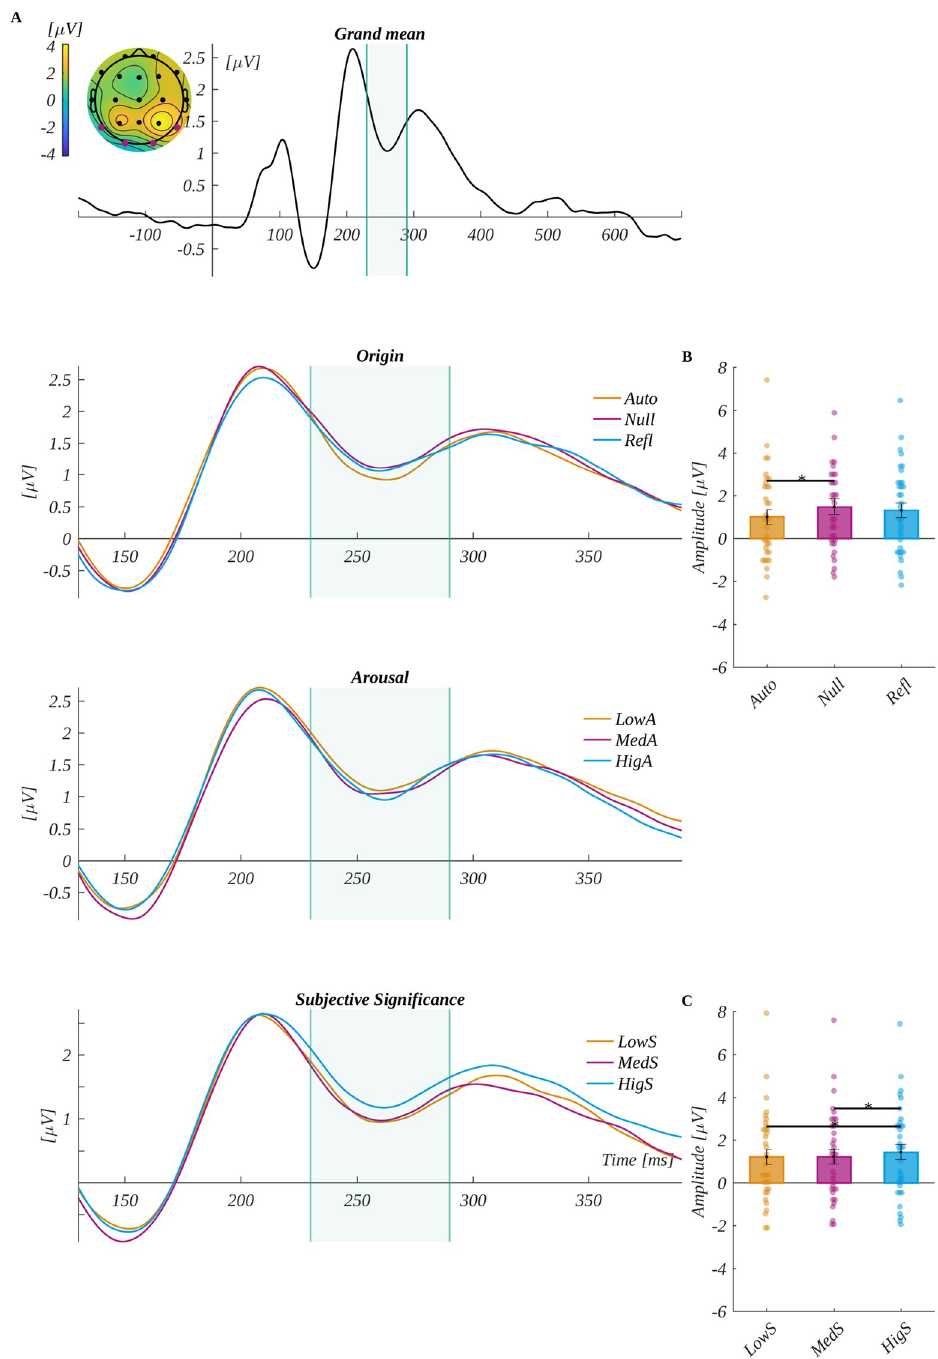
Fig 4. The EPN component results. The upper plot A is the grand average across electrodes from ROI EPN . The marked time-interval was selected for the EPN analysis. The insert shows the topography of the mean potential from this period with the electrodes forming the ROI EPN marked with pink dots. The three bottom plots are the time courses of ERP averaged across electrodes from ROI EPN for each level of origin, arousal and subjective significance. B Interaction between arousal and origin: differences between origin levels for medium arousal words. C Main effect for subjective significance. The bars represent the mean value, error bars SEM, individual dots mark the average amplitude of an individual subject in the given condition, the black horizontal lines indicate pairs of conditions with significantly different means ( � p < .05).